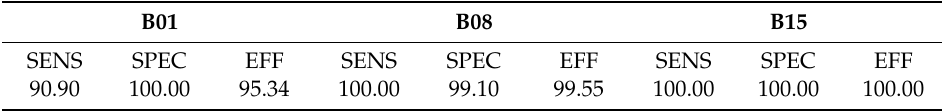
Table 9. PLS-DA classification results obtained in prediction on the EC signals acquired for models validation in laboratory conditions.